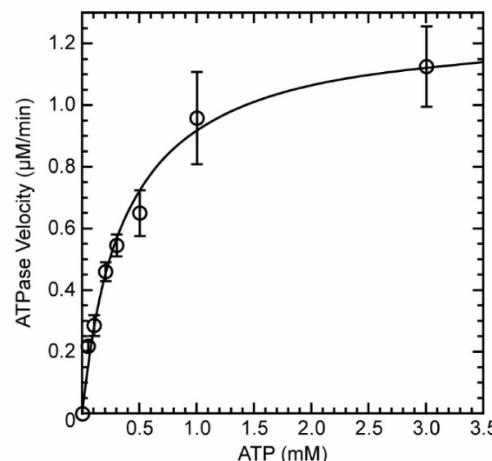
Figure 2. ATPase reaction velocities of eIF4A Mus with 340 ng/ µ L yRNA and different concentrations of ATP. The means and standard deviations are shown for three independent experiments. The values were fit to the nonlinear Michaelis-Menten equation using GraphPad Prism software. All the reactions were performed in the presence of 10% DMSO and 820 nM LieIF4A. Table 1. Rocaglamide has different effects on the ATPase activity of LieIF4A and eIF4A Mus . [yRNA] (ng/ µ L) Protein a b eIF4A